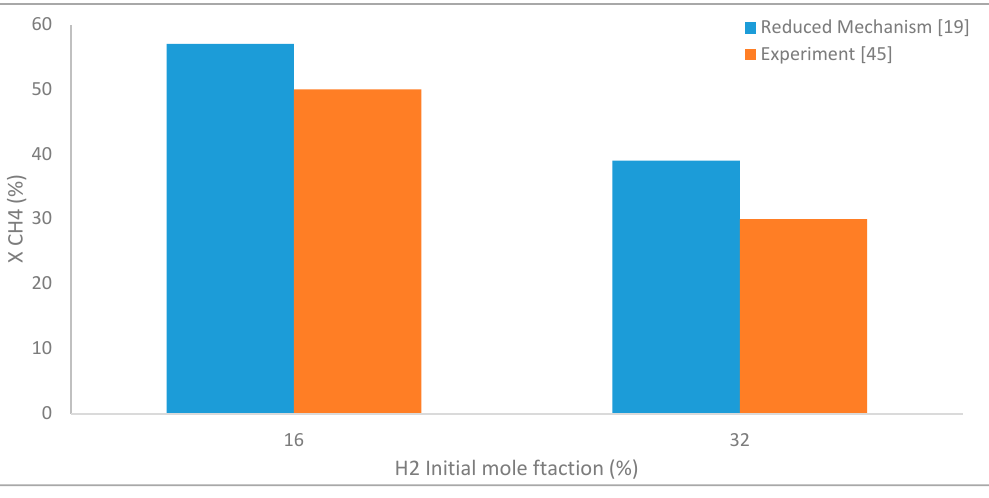
Figure 10. Effect of H 2 mole fraction on the conversion of CH 4 using the reduced mechanism [19] and the experimental data from Reference [45].